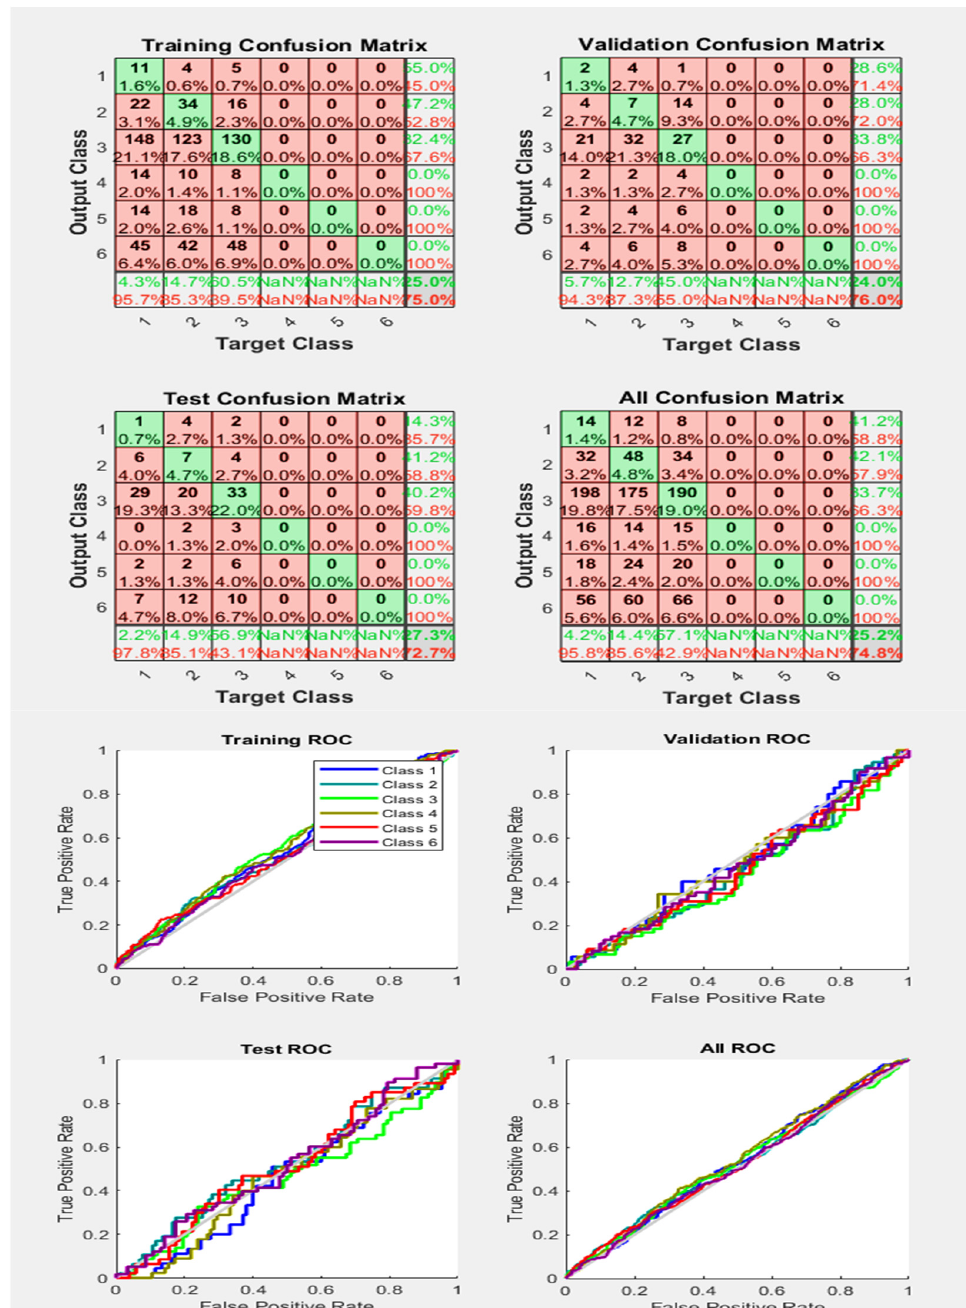
Figure 17. Neural Network Model ROC (Receiver Operating Characteristics) and Confusion Matrix for LM TrainFcn/Activation Function at level 9 (RMS) Features for High Contact Resistance Fault with 74.8% Accuracy. Grey line shows diagonal of the ROC for indicating Class 1–6 lines are lying above or below or on it.